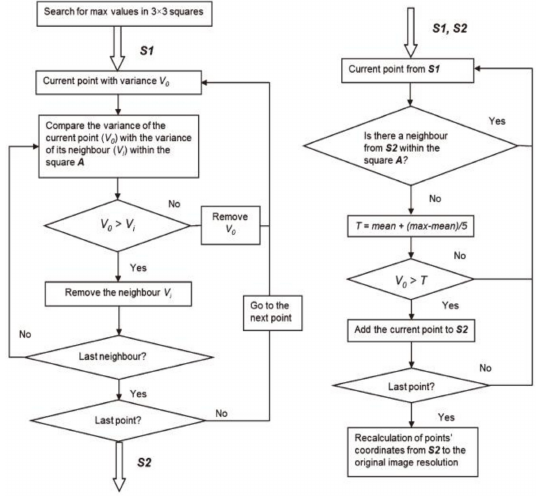
Figure 5. Selection of control points flowchart.